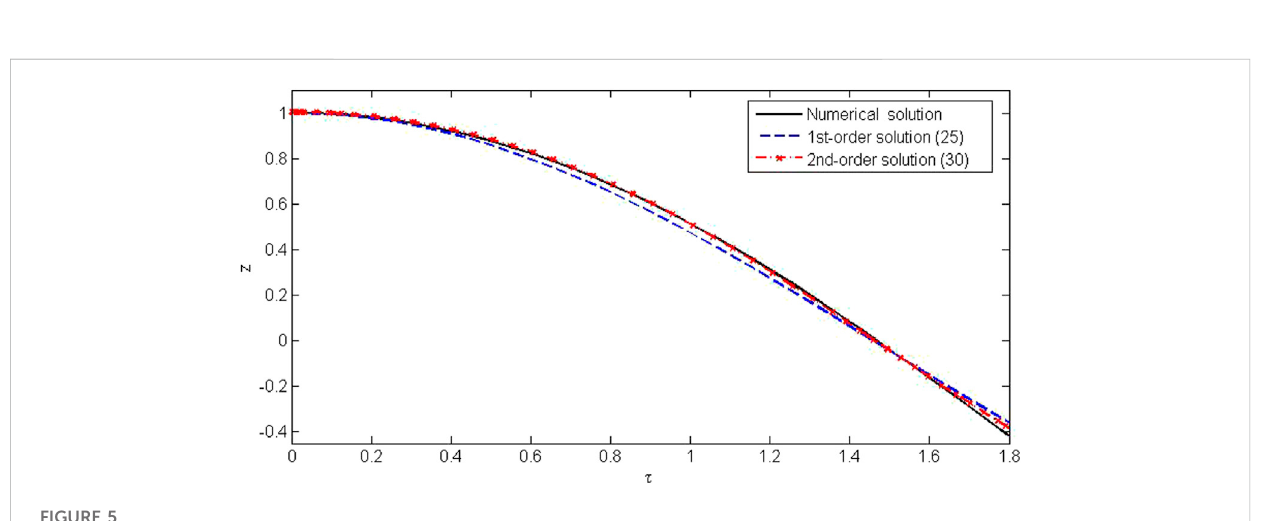
FIGURE 5 Comparison of the numerical solution with fi rst- and second-order solutions for A (cid:2) 1